Question: Write the caption for this figure.
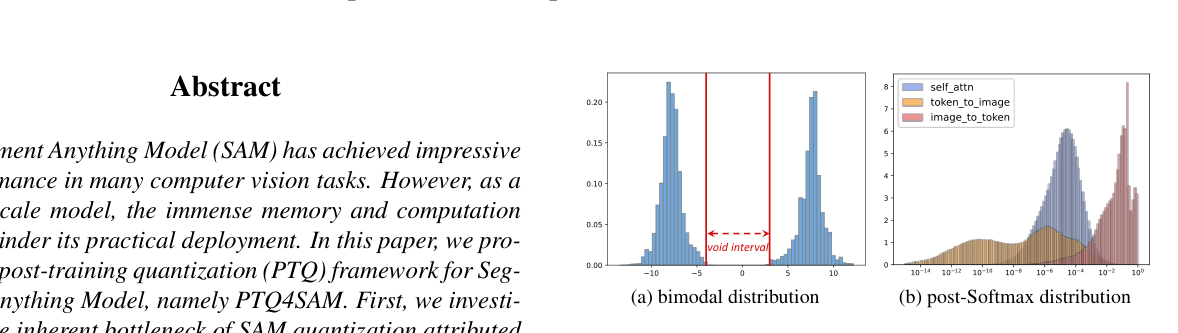
Answer: The histogram of two special distributions in SAM: (a) bimodal distribution in post-Key-Linear activations. (b) post-Softmax distributions of self-attention, token-to-image cross- attention and image-to-token cross-attention.